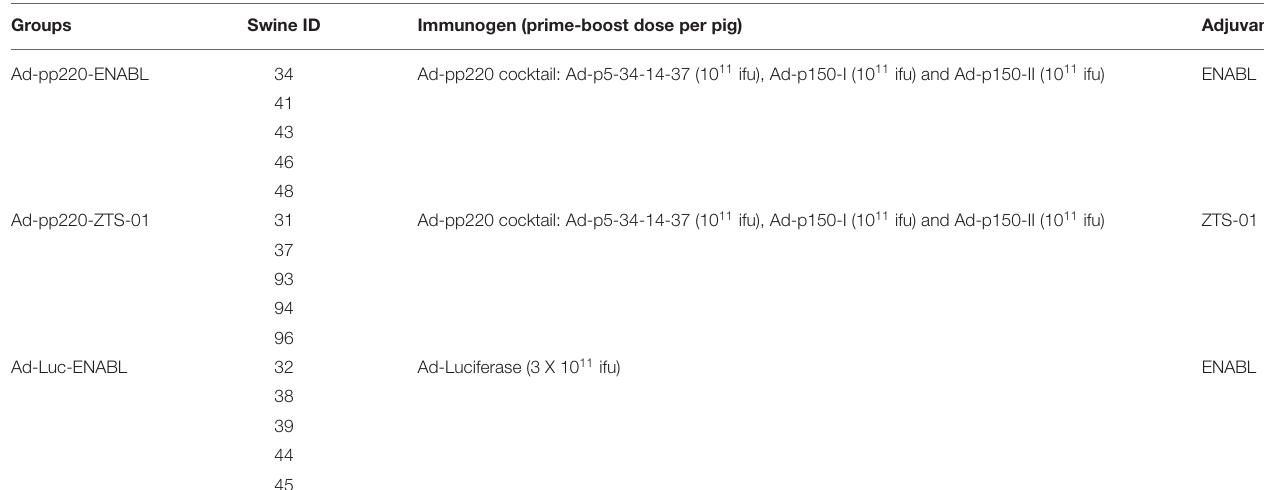
TABLE 1 | Swine immunization